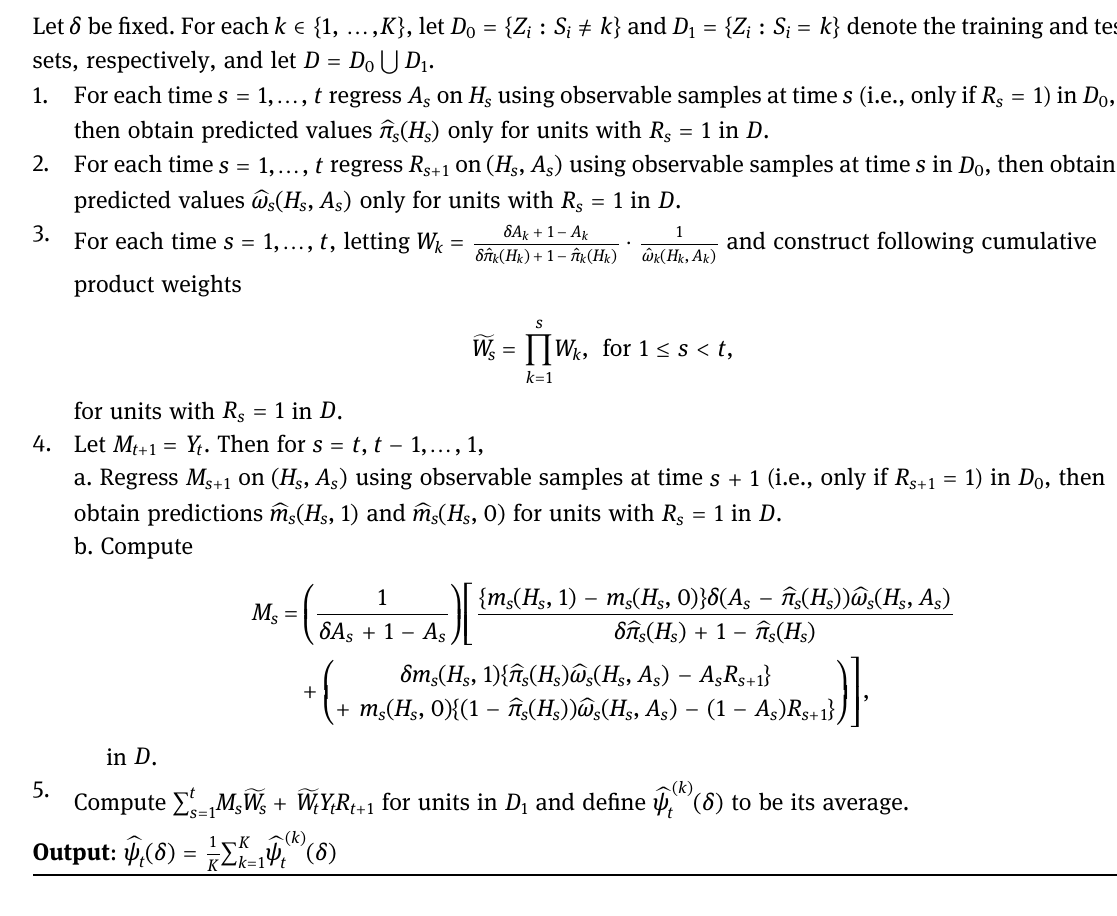
Algorithm 1 . Implementation of the proposed estimator ( 6 )